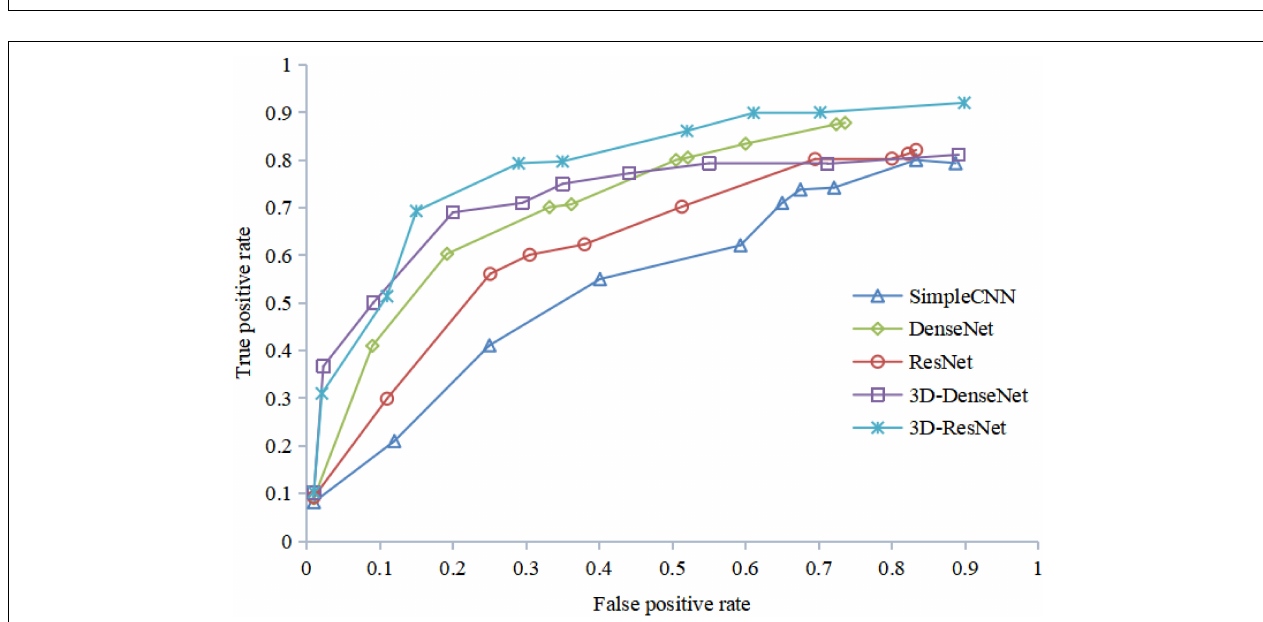
FIGURE 12 | ROC curves with FRN-Net for different backbones of the training set.